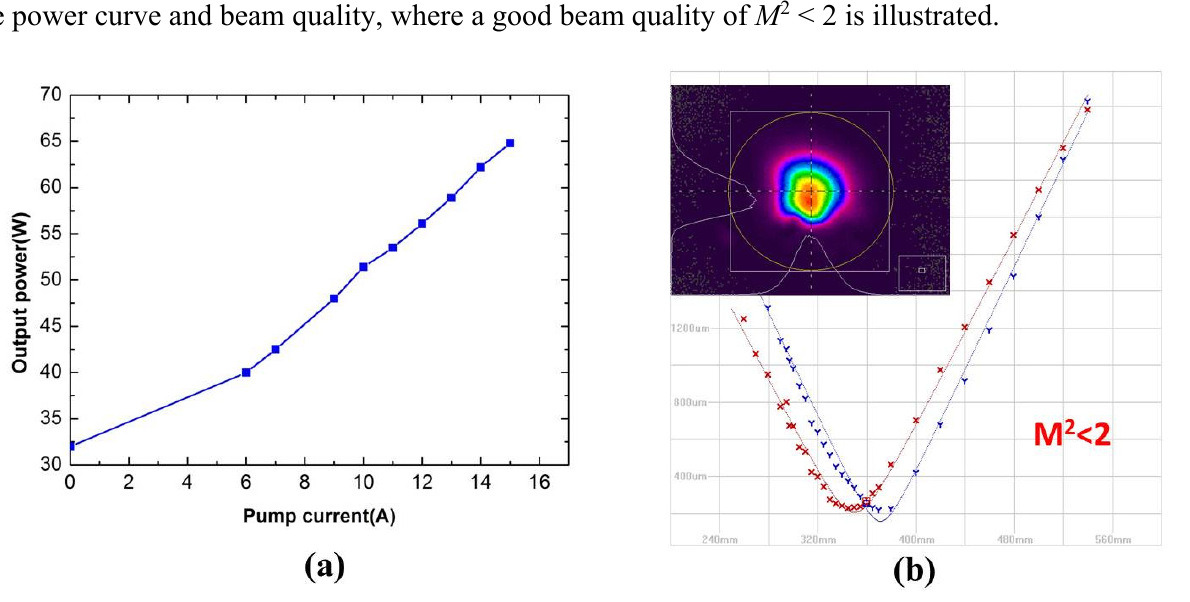
Figure 9. Power curve and beam quality of the side-pumped amplifier. ( a ) Power curve; ( b ) Beam